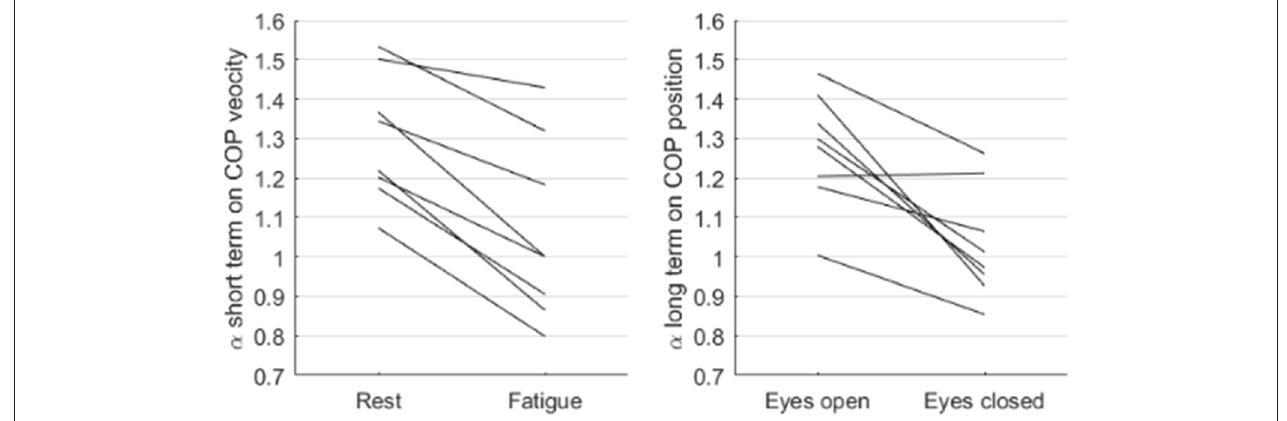
FIGURE 6 | Individual changes in short term scaling exponent on CoP velocity and long-term scaling exponent on CoP position, respectively with fatigue and eye closing, for all subjects.